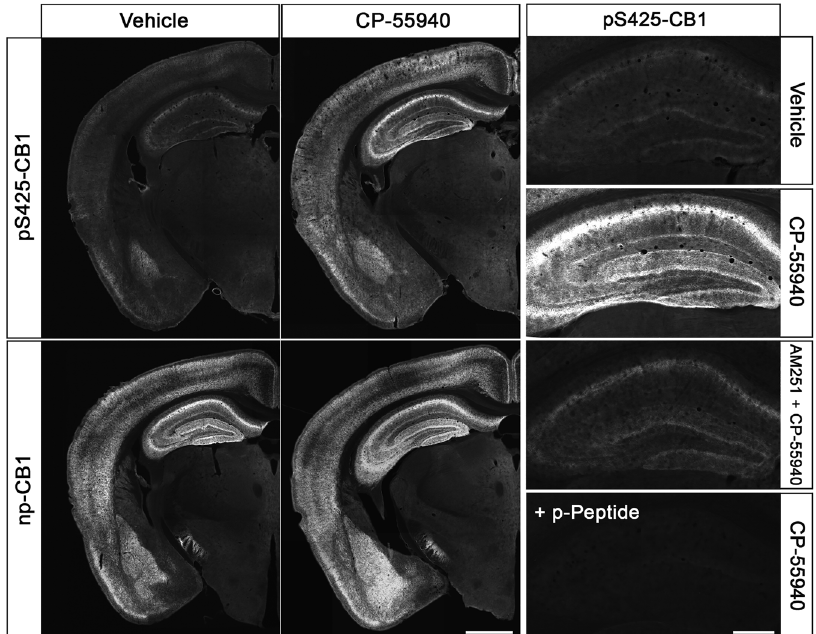
Fig. 8 Agonist-induced phospho-CB1 immunostaining in mouse brain. Animals were either treated with Vehicle or the CB1-agonist CP-55940 for 30 min. Where indicated, animals were pretreated with the CB1-antagonistAM251 for 45 min followed by 30 min CP-55940 treatment. Animals were then transcardially perfused, fi xed and stained in the presence of PPIs. Shown are confocal images of coronal brain sections stained with phosphosite-speci fi c antibody pS425-CB1, in the presence or absence of the p-Peptide containing S425 in phosphorylated form, or phosphorylation independent np-CB1 antibody. Note that agonist-induced phopho-CB1 immunostaining is diminished by antagonist treatment. Note that phospho-CB1 immunostaining was completely neutralized by excess of phosphorylated peptide. Scale bar = 1000 µ m and 250 µ m.